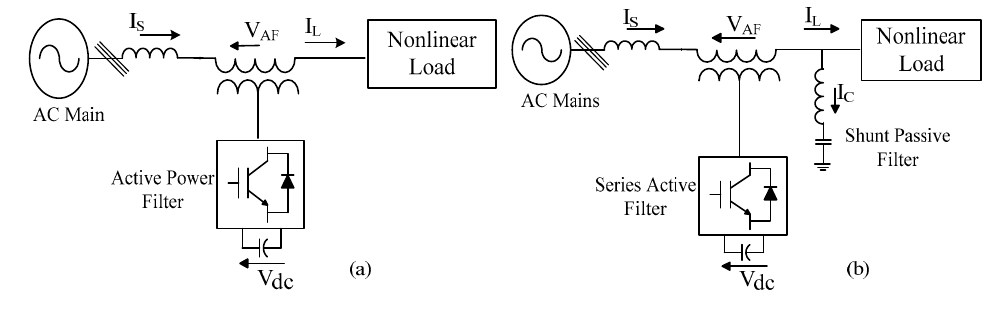
Figure 7. ( a ) Series and ( b ) hybrid APFs. Table 4. Comparison of APFs in terms of power quality improvement techniques.